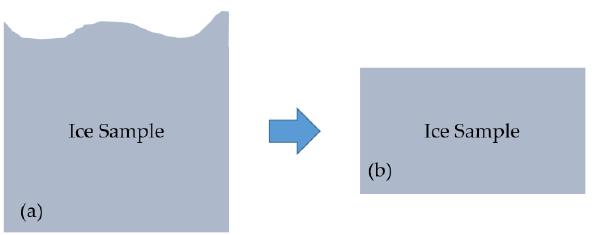
Figure 5. Cross section of ice sample. ( a ) Before processing. ( b ) After processing.